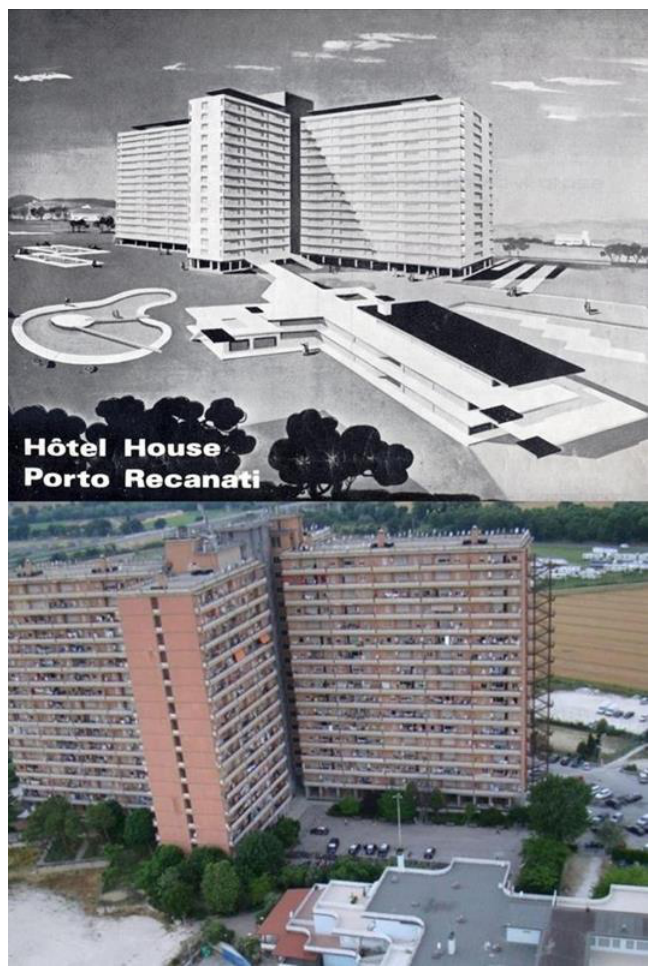
Figure 1. The original architectural project of the Hotel House. The building at present.